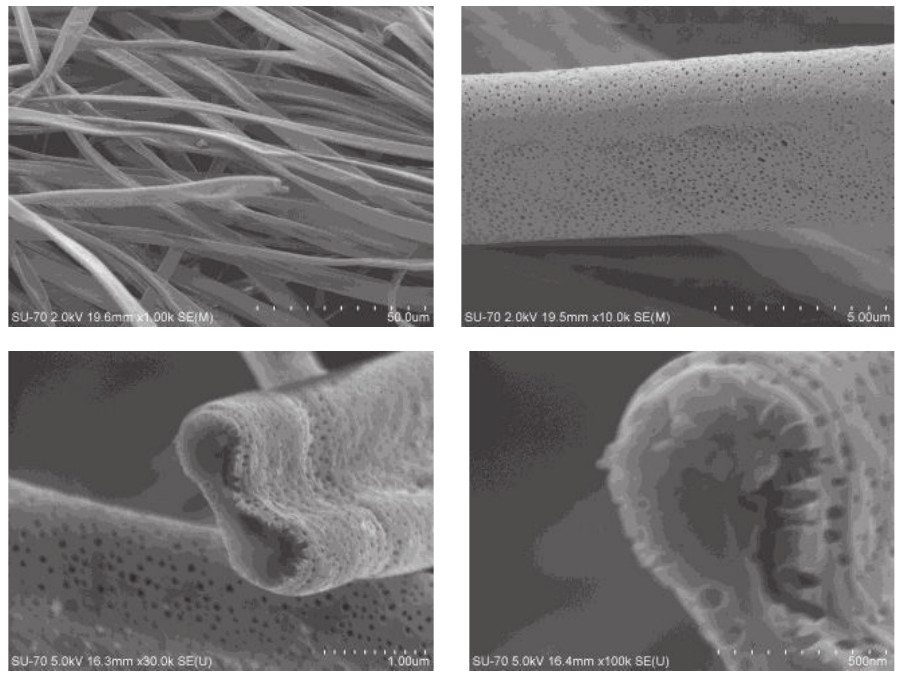
Figure 6: Scanning electron micrographs of polymer 2 b